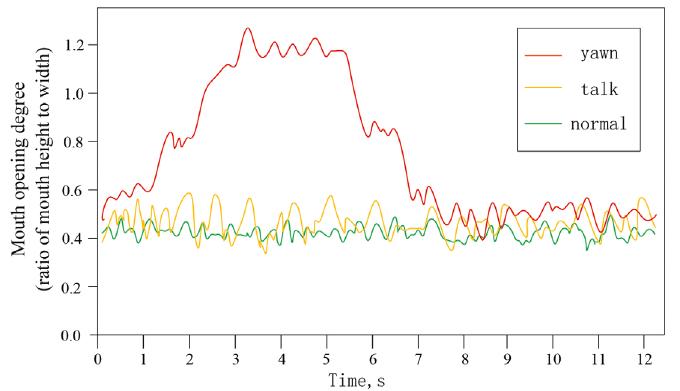
Figure 3. Mouth opening degree in different driver’s states